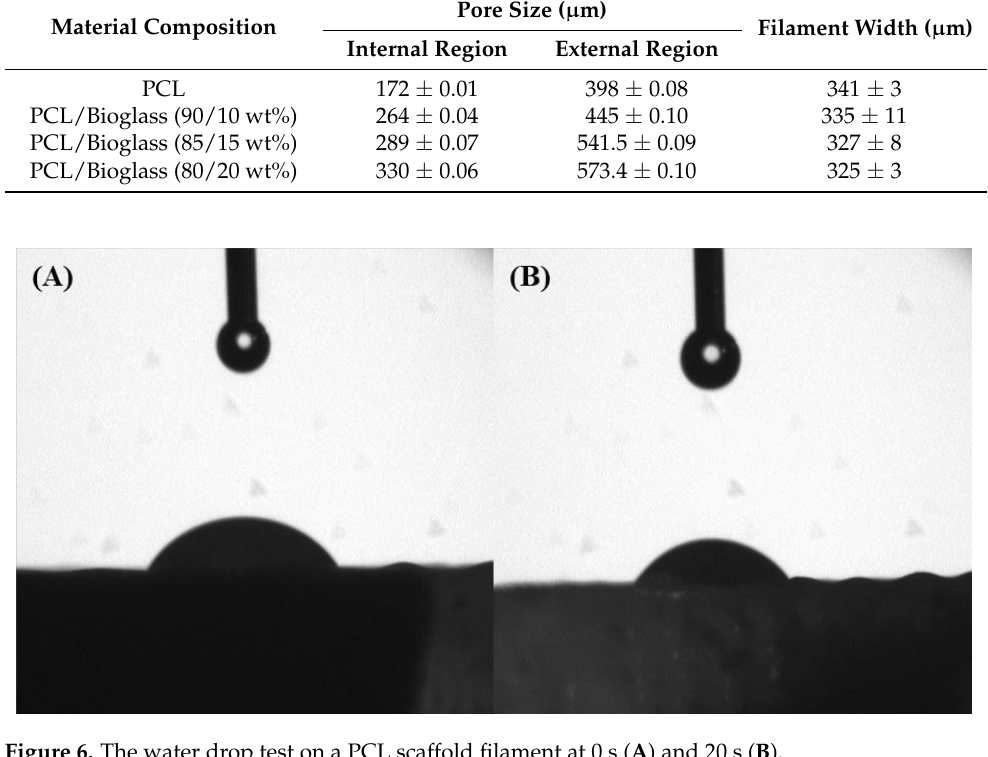
Table 2. The WCA results of the different regions of the scaffolds and the different time points.